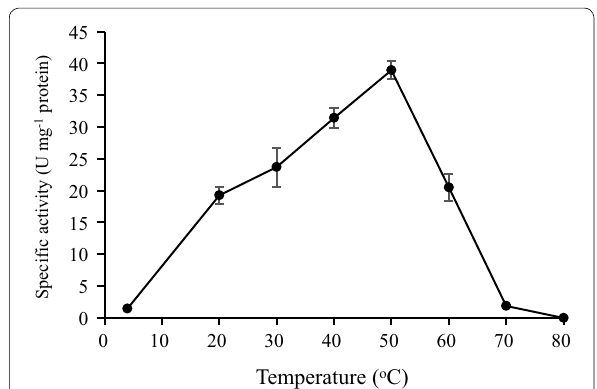
Fig. 7 Effect of temperature on the AMG activity. The enzyme was incubated at the temperature of 4 to 80 °C for 1 h. All error bars are represented as the standard errors of the means (SEM)